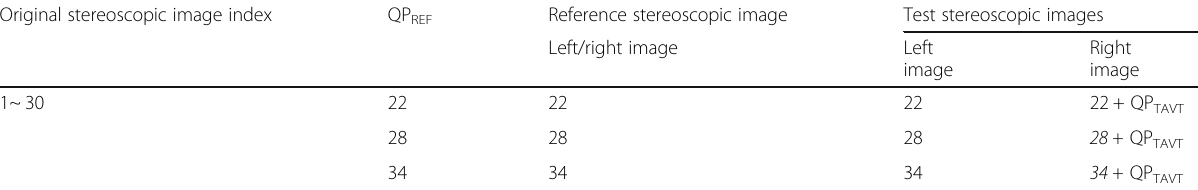
Table 3 The selection of QP for subjective experiment Original stereoscopic image index